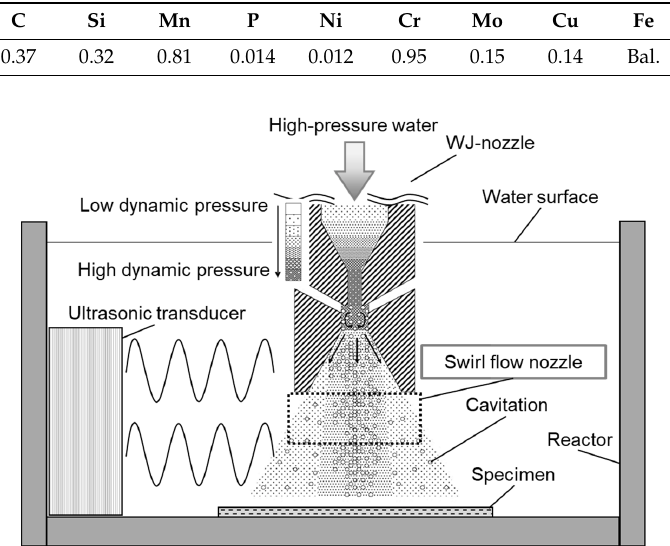
Figure 1. Equipment used for surface machining using water jet peening (WJP) with ultrasonic waves.